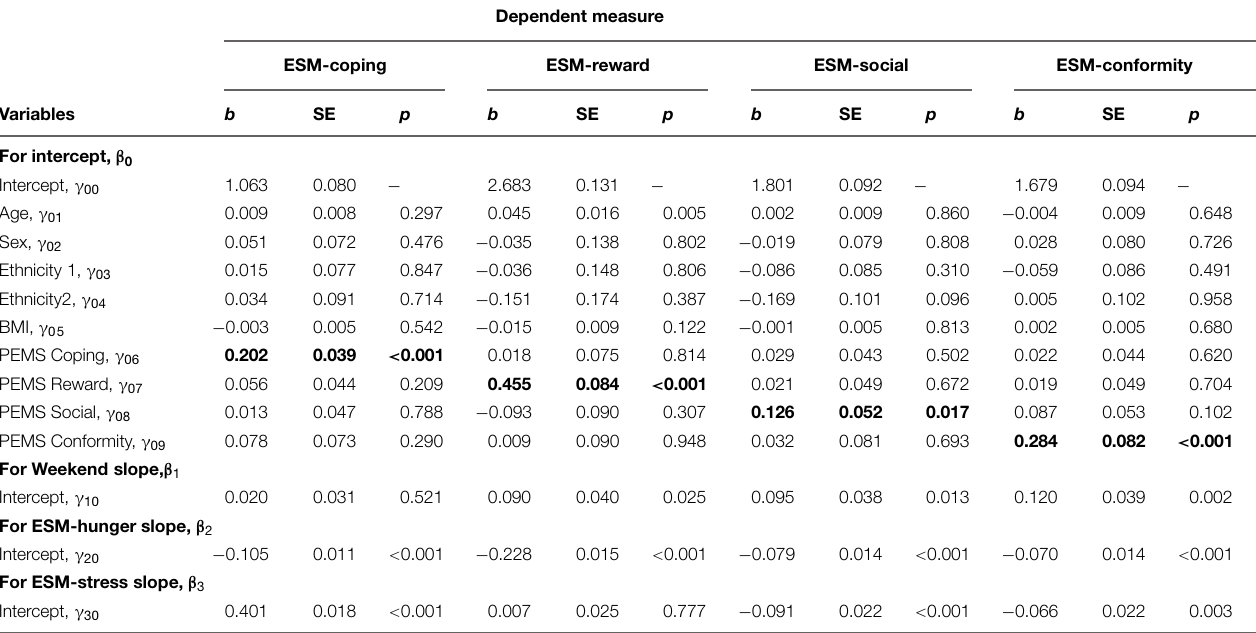
TABLE 2 | Results from two-level mixed models predicting ESM-reported motives from the PEMS and covariates.